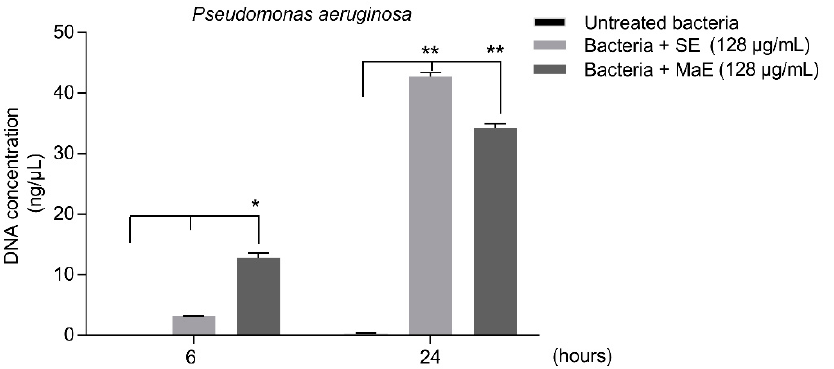
Figure 3. Effect of P. americana seed ethanol extracts on Pseudomonas aeruginosa ATCC 9027 membrane integrity. SE: ethanol extract obtained by Soxhlet; MaE: ethanol extract obtained by maceration. P. aeruginosa membrane impairment was evaluated by measuring the release of nucleic acids. P. aeruginosa suspensions were incubated at 37 °C in the presence of plant extracts (128 µg/mL) during a 4h period. After centrifugation, supernatants were collected at 6 and 24 h and the optical density (OD) was recorded at 260 nm. All values are expressed as the arithmetic mean ± SD. (**) and (*) Significant differences at 1% and 5 % levels according to one-way ANOVA test followed by the Tukey’s test ( n = 4).